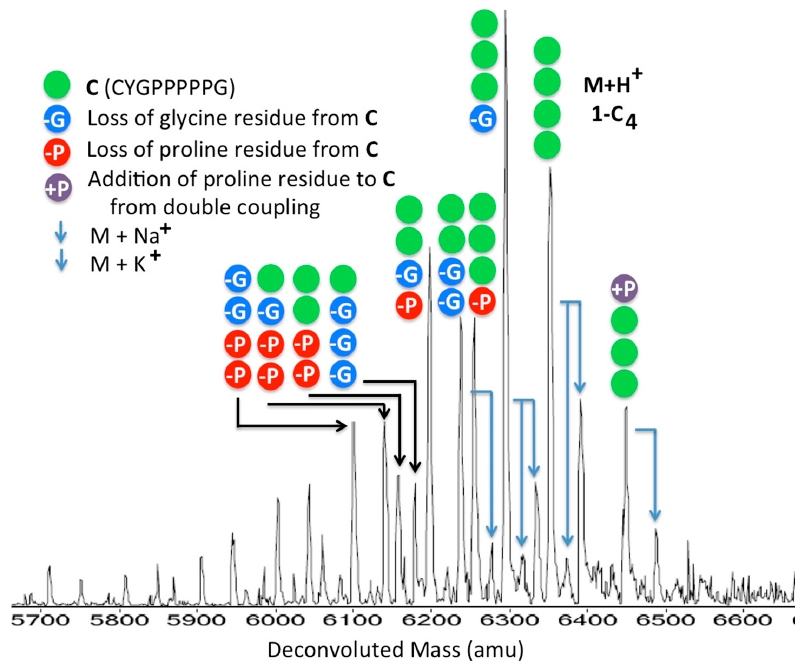
Figure 2. Tentative assignment of the products of conjugation of peptide C with 1 to yield 1-C 4 .